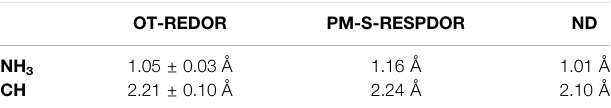
TABLE 1 | 1 H- 14 N distances measured by OT-REDOR, PM-S-RESPDOR, and ND on Tyr.